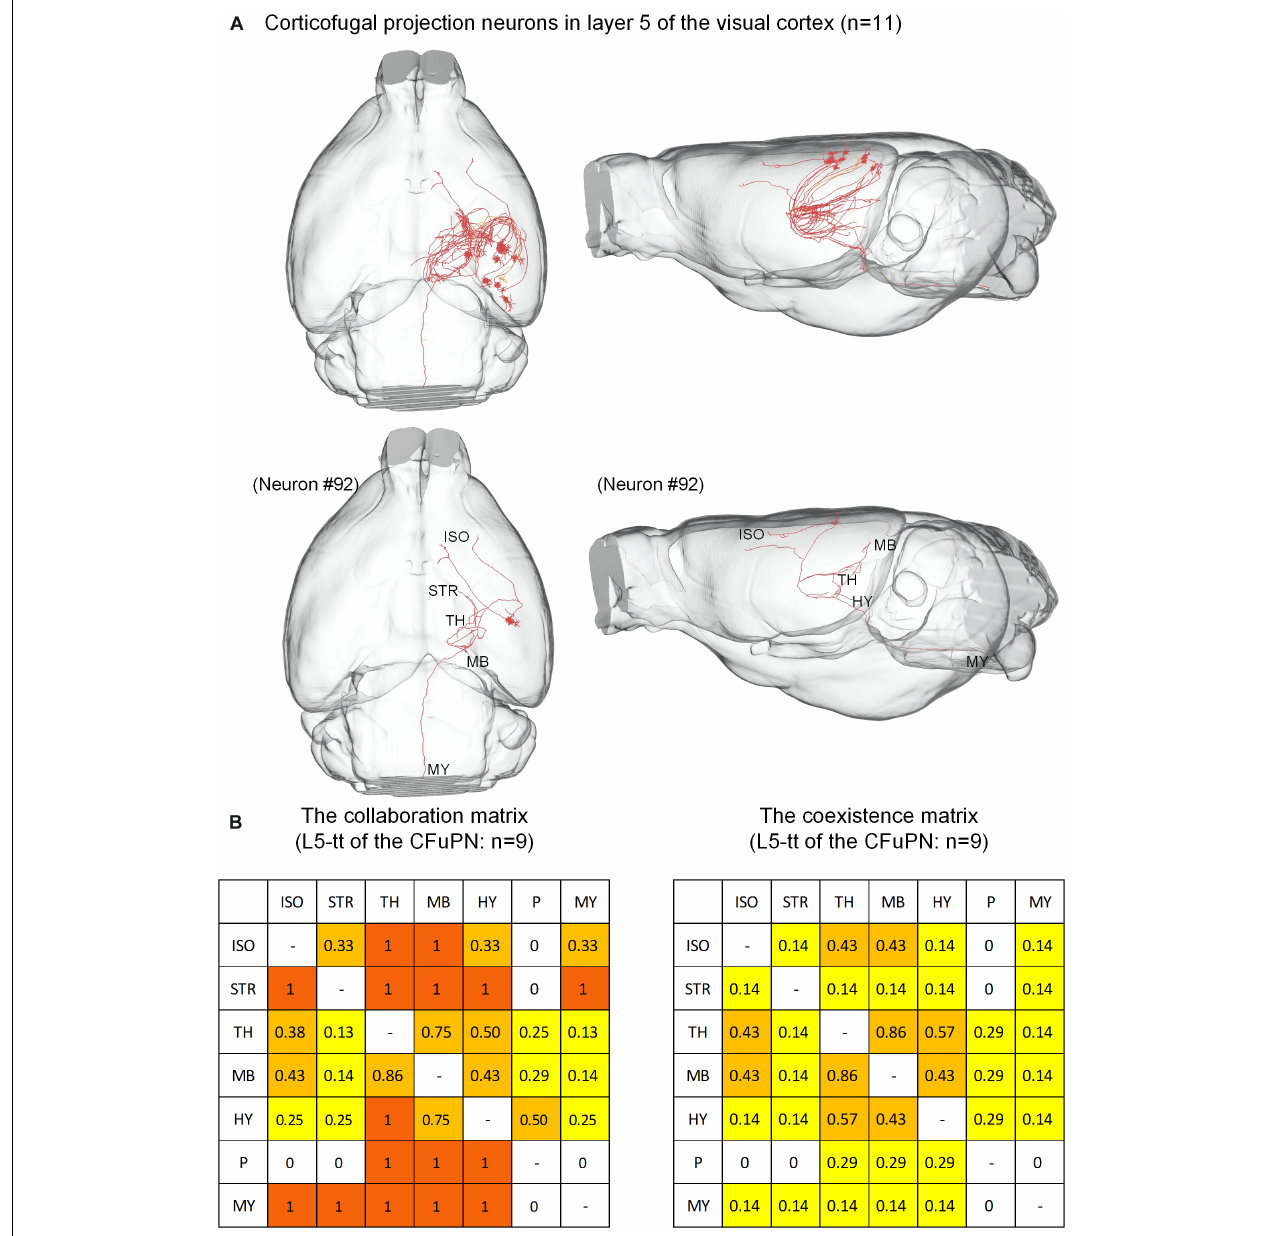
FIGURE 5 | Distribution of axon terminals for the CFuPN in L5. (A) In the panel of top row, the 11 CFuPN in L5 with their complete morphologies are shown in the mouse brain. In the panel of bottom row, a typical neuron (#92) presents multiple axonal terminals in different brain regions. (B) The L5-tt of CFuPN: n = 9. The collaboration matrix of L5-tt of the CFuPN quantifies the “posterior probability” of another projection region given the neuron projection to the current region. Taking the values in the first row and second column as examples, “0.33” means 33% of the neurons projected to isocortex project to striatum. The values in the first row and third column: “1” means the neurons projected to isocortex must project to thalamus. The coexistence matrix of L5-tt of the CFuPN measures the occurrence frequency of two directional projection modes. Every element of the matrix represents the ratio of some neurons projecting to the two regions to all the neurons having at least two projection